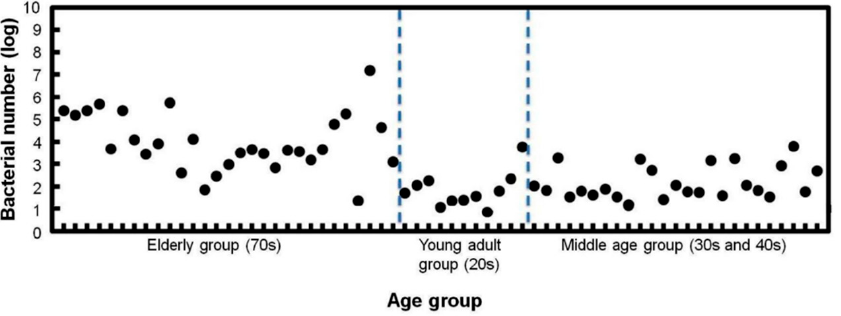
Figure 12. Electrochemical measurement of periodontal bacteria in saliva with different age groups [15]. Saliva samples were collected from 20s group (18 people) 30~40s group (24 people) 70s~group (33 people).